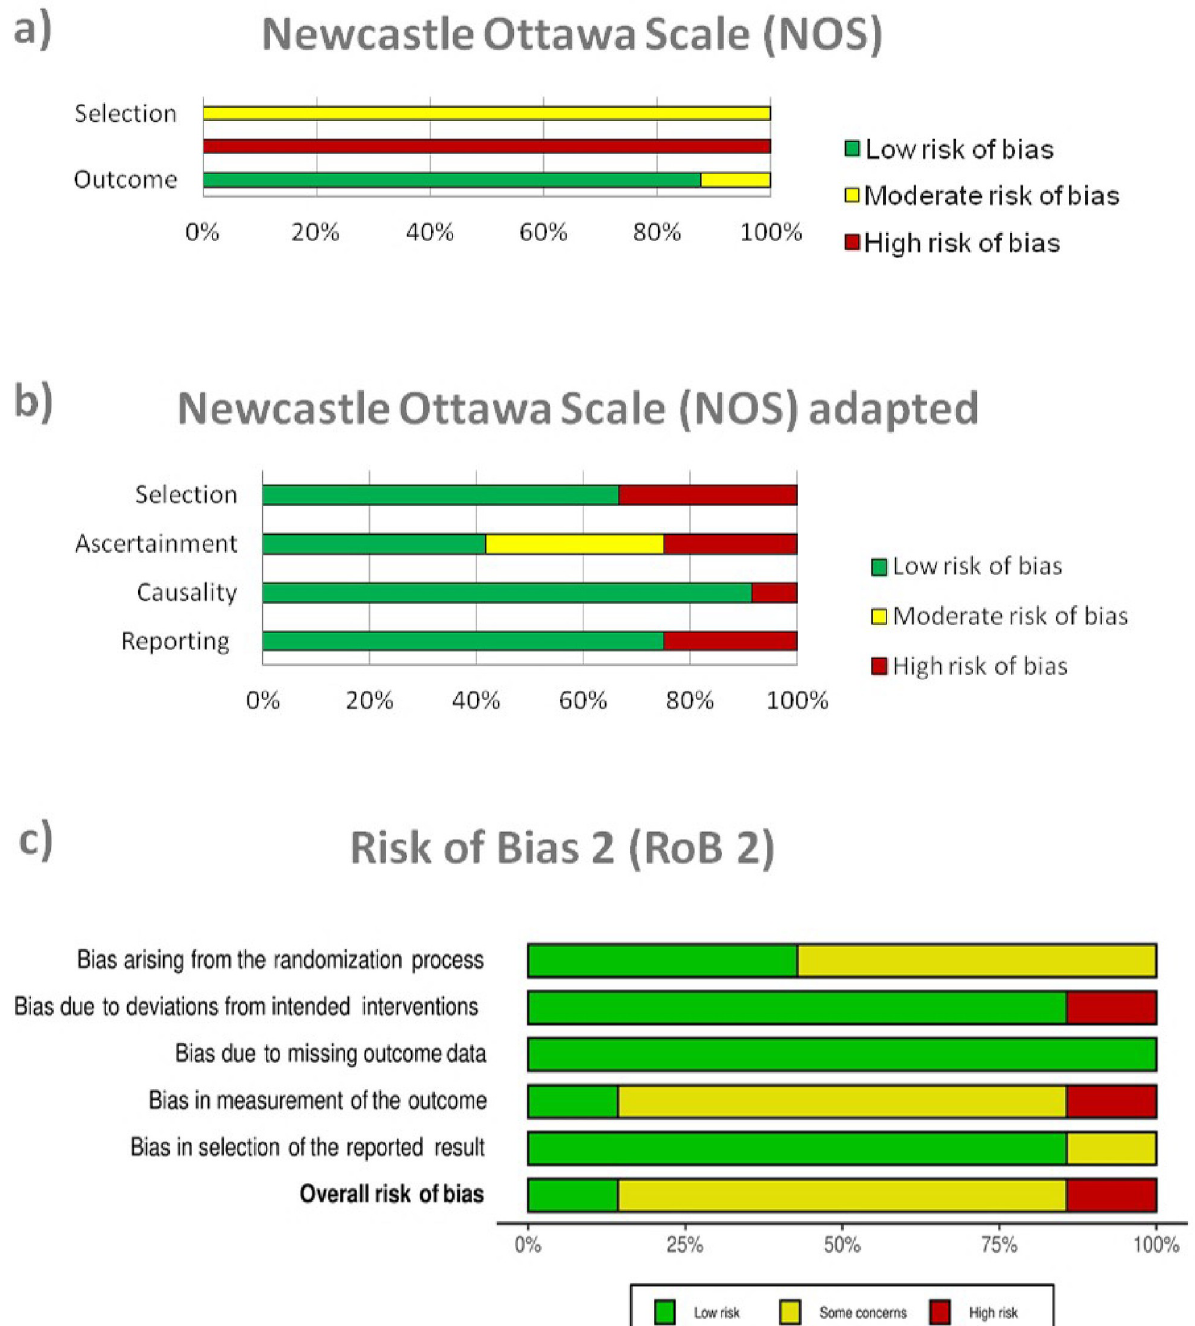
Fig 10. Risk of bias